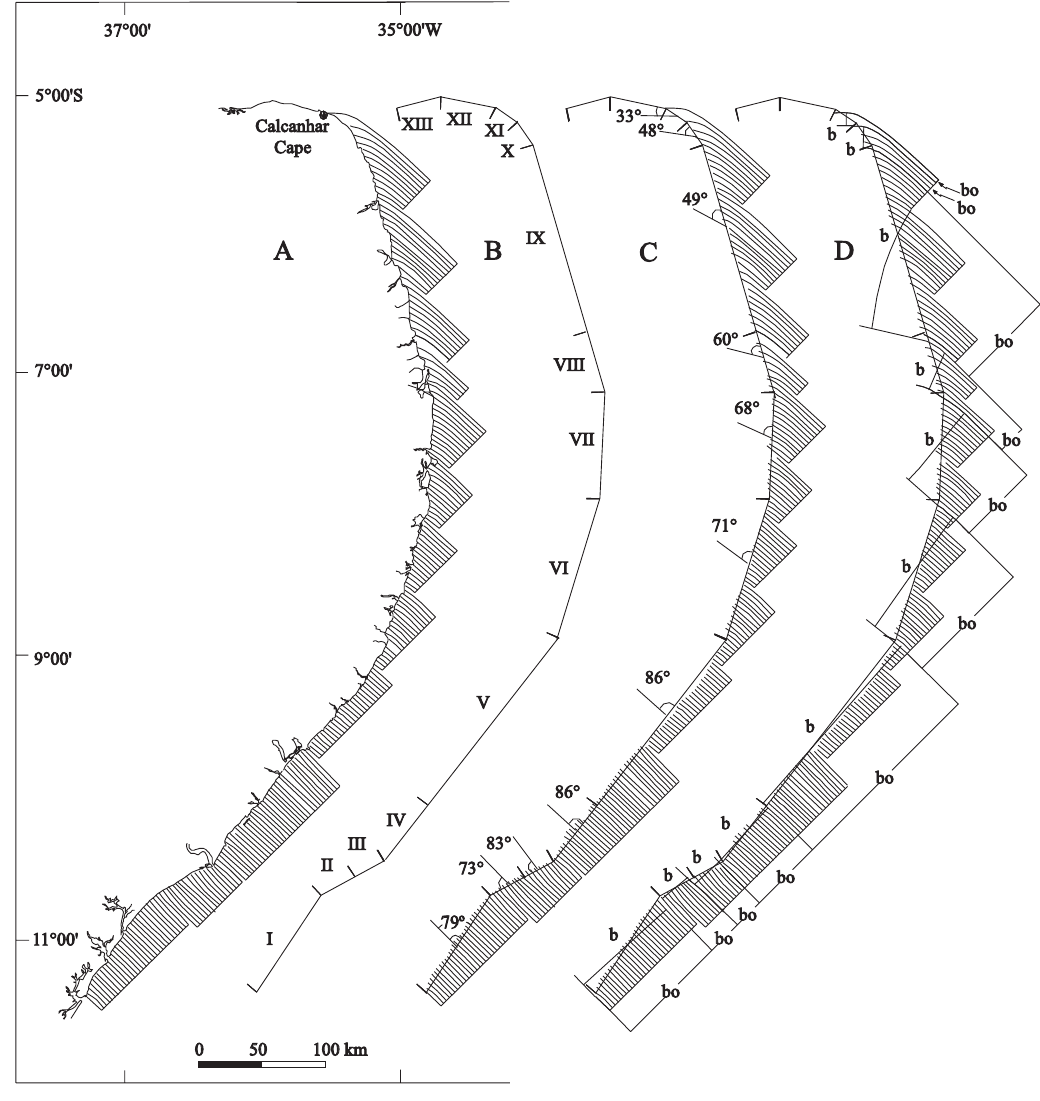
Fig. 4 – A – Refraction diagram for waves with a 6.5 sec period, arising from the SE ( N135 ◦ ) . B – Different segments in which the coastline has been rectilinearized. C – Incidence angles formed by waves from SE in relation to the rectilinearized coastal segments. D – Measurements of b and b o for estimating the height of waves along the rectilinearized coastal segments.